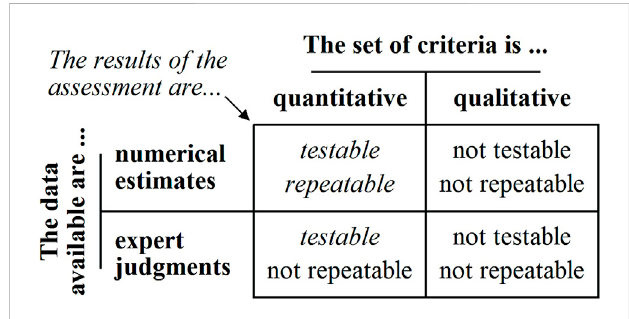
The nature of the results obtained (repeatable and/or testable), given a certain set of criteria (quantitative or qualitative) and a certain type of data (numerical or expert